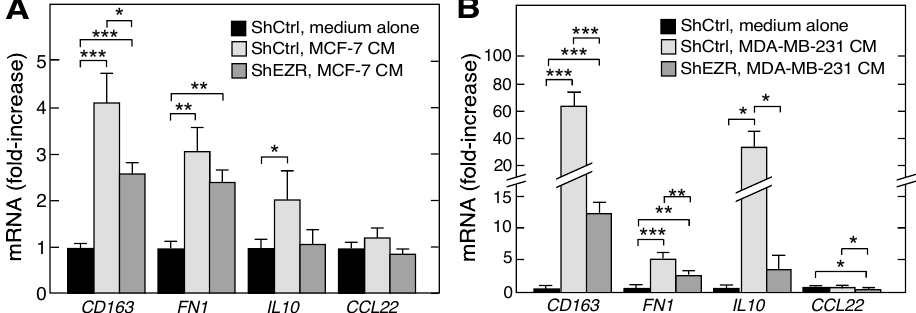
Figure 4. Role of ezrin in tumor cell-driven myeloid cell polarization. ( A , B ) ShEZR and ShCtrl cells were incubated with CM from MCF-7 ( A ) or MDA-MB-231 ( B ) cells, or with medium alone, and mRNAs encoding M2 marker proteins determined by RT-qPCR, and normalized to ShCtrl medium alone cells. Mean ± standard deviation; *, **, and *** indicate p < 0.05, 0.01, and 0.001,